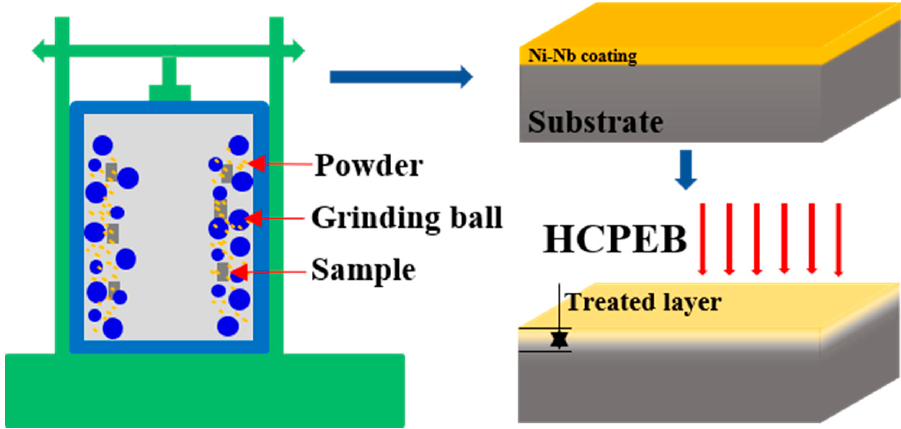
Figure 1. Schematic diagram of experimental process.